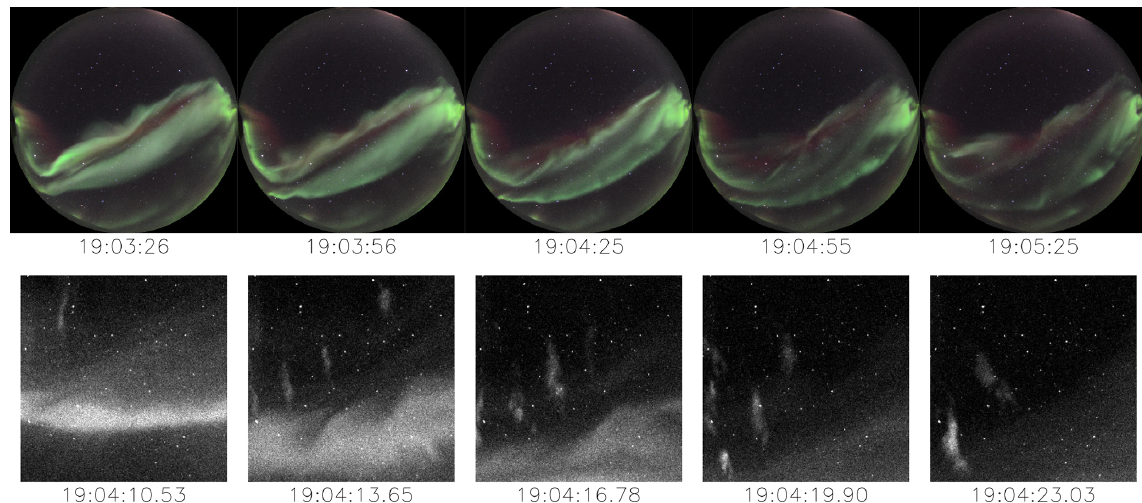
Figure 1. Event 1 on 4 December 2013. The top row shows colour all-sky camera images, with the time at the start of the exposure given below each frame. The bottom row shows selected ASK images of N 2 1P emission at 673.0nm.